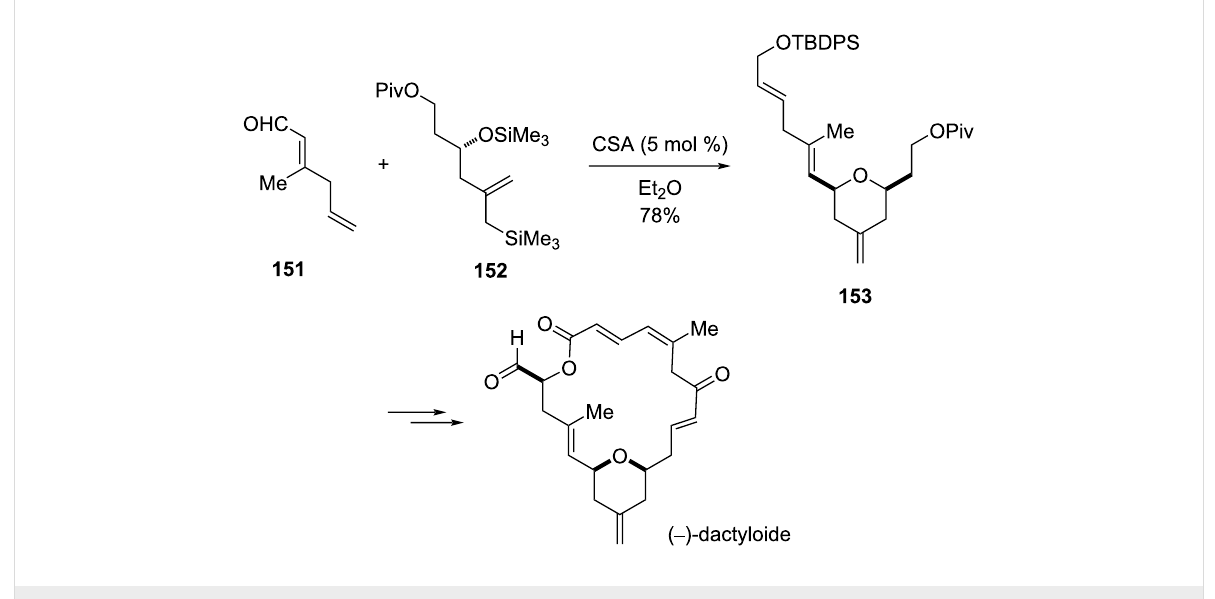
Scheme 36: Hoye and Hu’s synthesis of ( − )-dactyloide by intramolecular Sakurai cyclization.